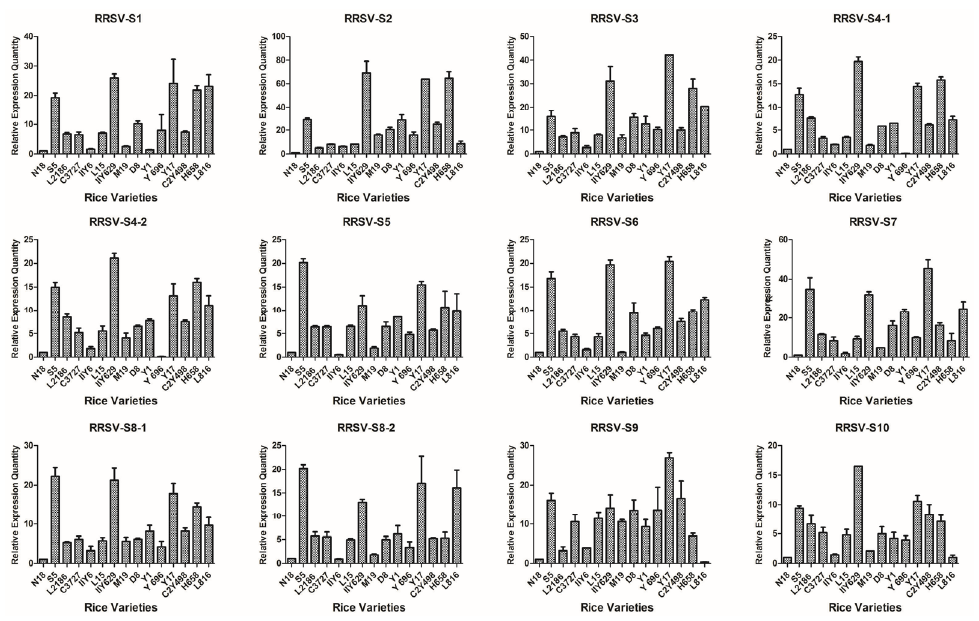
Figure 4. Map generated from the responses of 15 dual infestation rice varieties to 12 RRSV genomes. All rice varieties consisted of N18 (1), S5 (2), L2186 (3), Chuanyou3727 (4), IIY6 (5), L15 (6), IIY629 (7), M19 (8), D8 (9), Y1 (10), Y696 (11), Y17 (12), C2Y498 (13), H658 (14), and L816 (15).